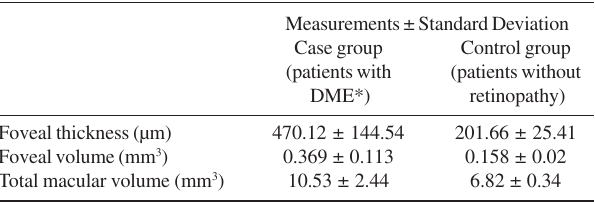
Table 1 - Mean foveal thickness, foveal volume and total macular volume in the case group and the control